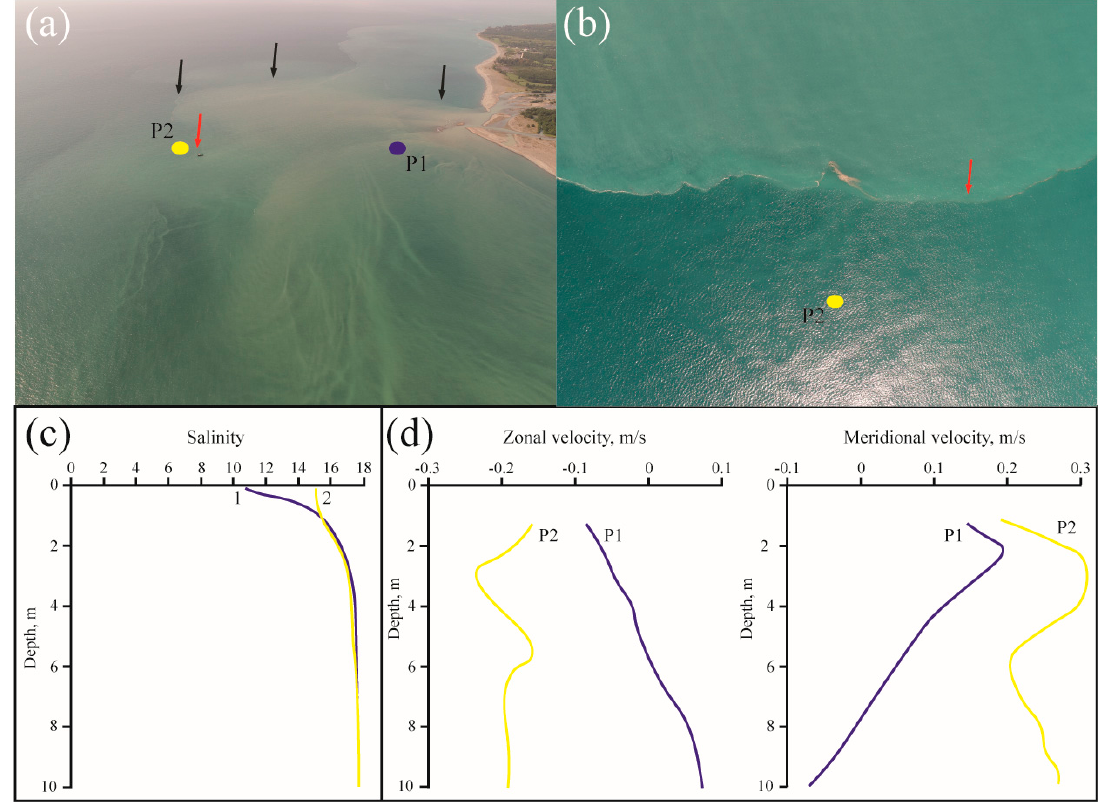
Figure 5. ( a,b ) aerial images, ( c ) vertical salinity, and ( d ) velocity profiles at the frontal zone between the emergent and the residual parts of the Kodor plume on 2 September 2018. Colored dots indicate locations of vertical salinity and velocity measurements (P1, blue—the emergent plume; P2, yellow—the residual plume). Arrows in panels ( a ) and ( b ) indicate distinct frontal zones between the emergent and the residual parts of the Kodor plume. Red arrows in panels ( a ) and ( b ) point at the same segment of the frontal zone where in situ measurements were